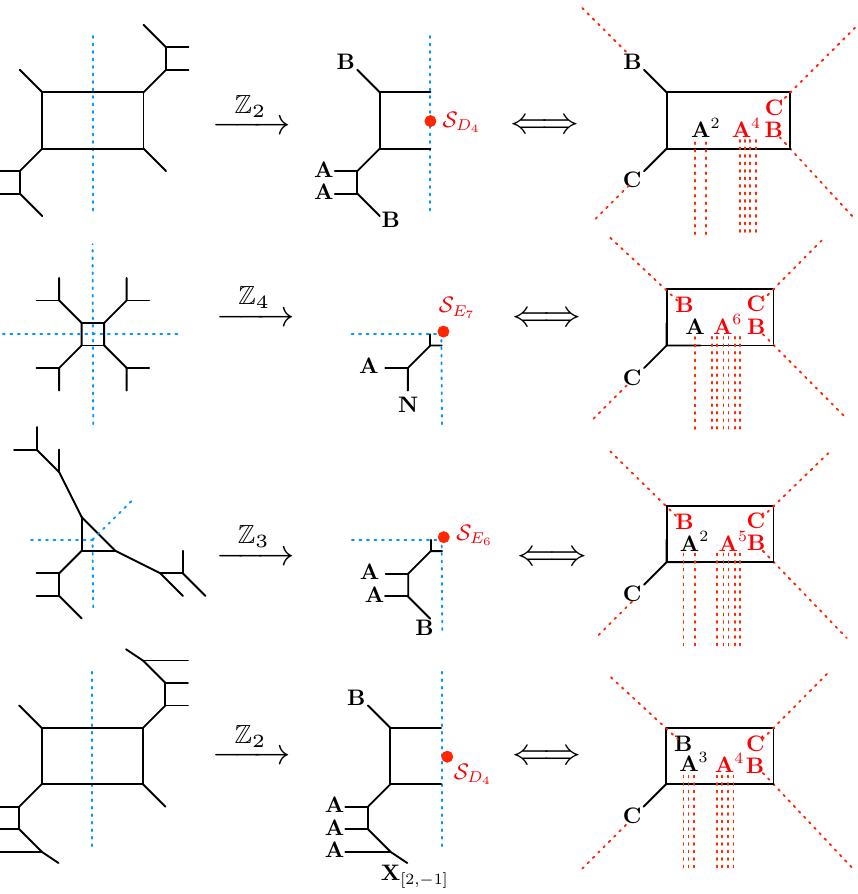
Figure 13 . Other S-foldings of rank-1 theories and the resulting brane webs of b E n configurations, given in (2.17) and also in figure